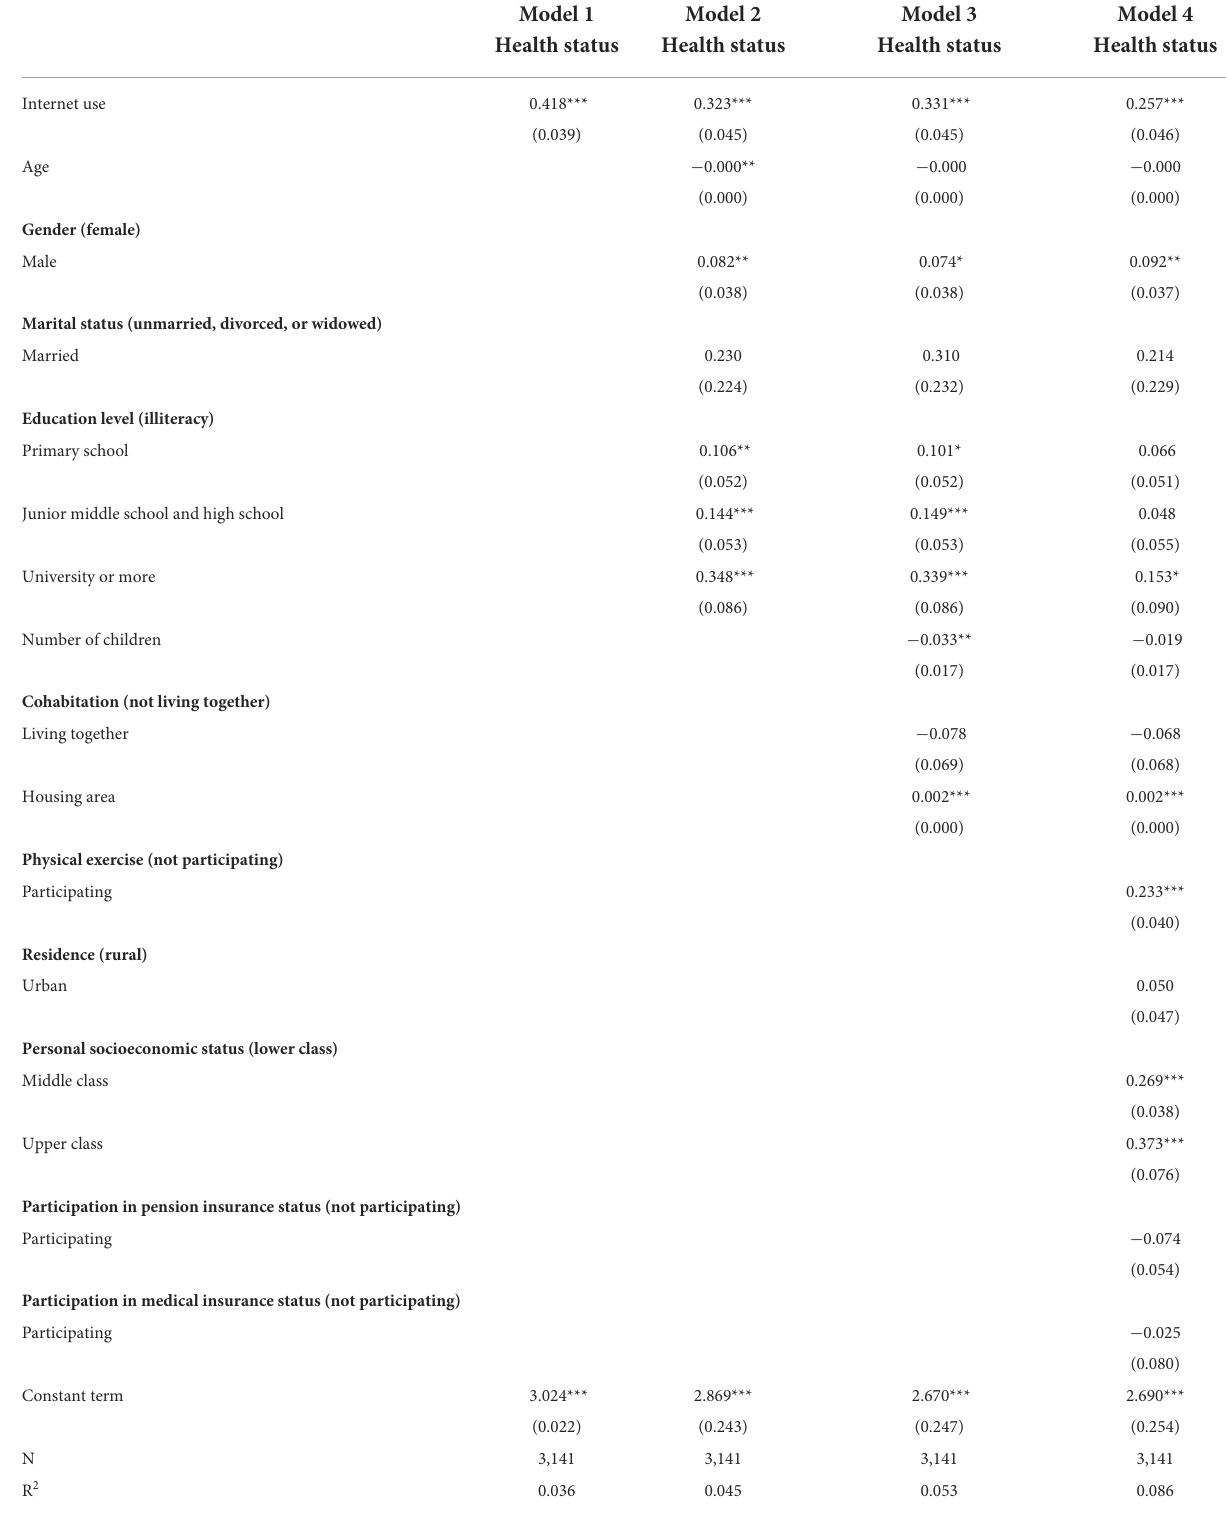
TABLE 2 Regression analysis of Internet use on health status of older